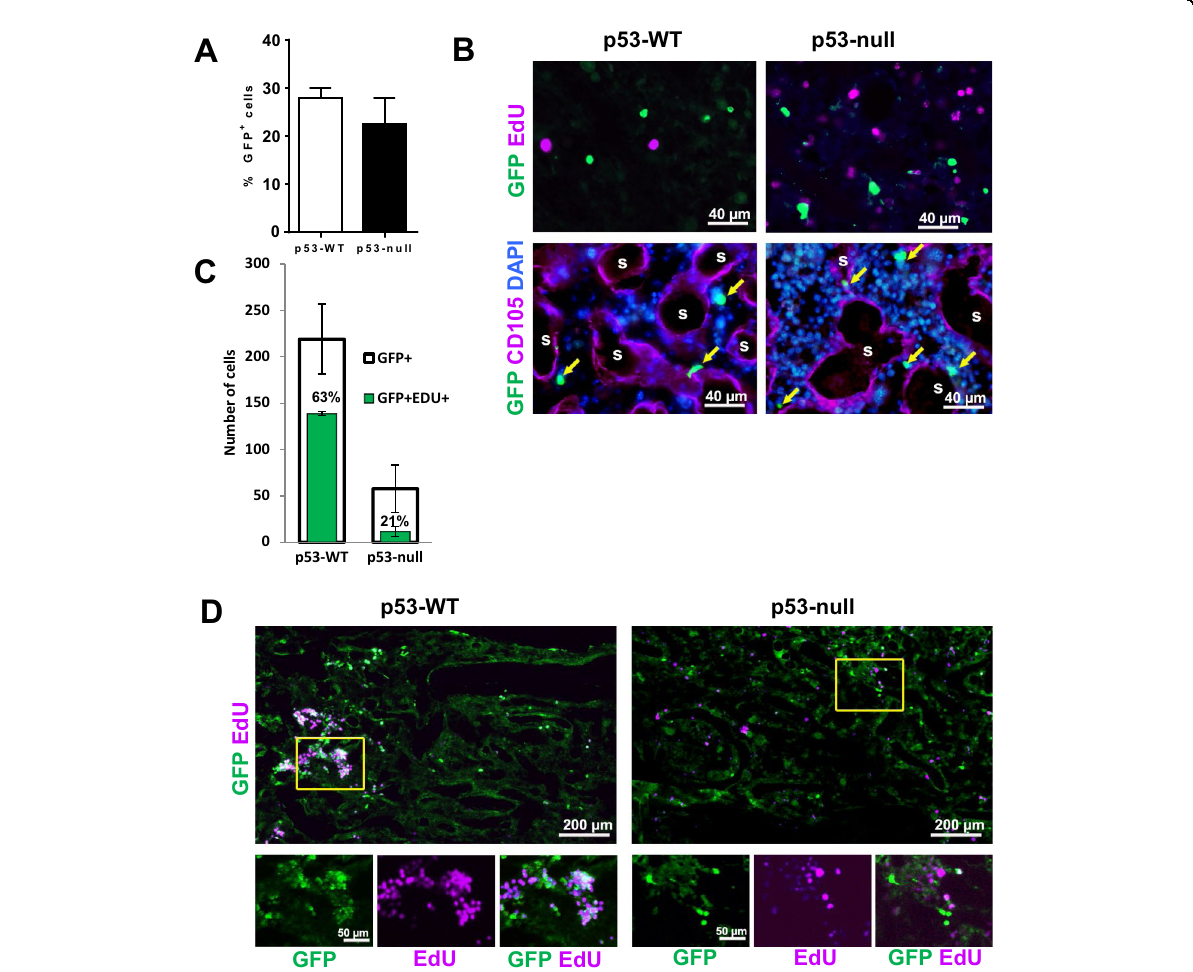
Fig. 2 Transplanted BM cells migrate to the BM in p53-null mice, but do not proliferate there. A – B BM cells transplanted into irradiated mice by tail vein infusion migrate to the BM in both p53-WT and p53-null mice. A BM cells (1 × 10 7 ) from GFP-expressing mice (C57BL/6-Tg(UBC-GFP) 30 Scha/J) were adoptively transferred via the tail vein into recipient syngeneic p53-WT or p53-null hosts (C57BL/6) that were preconditioned with 13 Gy TBI. In all, 24 h post BMT, BM cells were collected from the femurs of recipient mice to quantify GFP-expressing cells within the BM compartment by FACS (percentage of GFP + cells among total BM cells). Results are mean from three mice analyzed individually. Error bars signify SEM. B Longitudinal sections of femoral BM from mice described in A were prepared 72 h post BMT and stained for EdU (proliferation marker), GFP (marker of donor cells), CD105 (marker of sinusoidal endothelium), and DAPI (DNA marker). “ S ” -sinusoid; yellow arrows indicate GFP + cells. C Quantitation of the experiment described in D . The average number of GFP + and EdU + GFP + cells per the counted fi eld is shown for p53-WT and p53-null BM 72 h post BMT (EdU + GFP + and GFP + cells were counted in three fi elds of the images taken with objective ×5). Error bars signify SEM. The difference between p53-null and p53-WT EdU + GFP + cells was statistically signi fi cant ( P = 0.009 by two-tailed t test). The percentage of Edu + GFP + cells relative to all GFP + cells is shown for p53-WT (63%) and p53-null (21%) mice. D Transplanted BM cells do not proliferate in the BM of p53-null mice. BM cells (1 × 10 7 ) from GFP-expressing mice were adoptively transferred via the tail vein into recipient syngeneic p53-WT or p53-null hosts (C57BL/6) that were preconditioned with 11 Gy TBI. Longitudinal sections of femoral BM were prepared 72 h post BMT and stained for EdU and GFP. Boxed areas from each low magni fi cation (×10) image are shown below at higher magni fi cation (×40) with individual and overlapped stains. For B and C , EdU was injected intraperitoneally 1h before mouse sacri fi ce. Representative images from four mice of each genotype are shown and the area of the femur corresponding to the sections that are shown is indicated by a box on the schematic of the femur